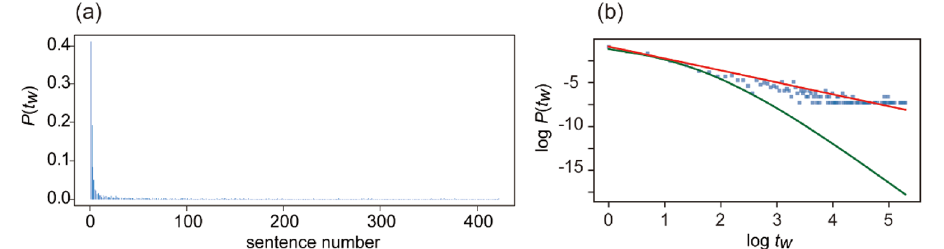
and ( b ) log–log scale plot. The red straight line and the green curve t , for w show optimized fitted results by use of the hierarchical distribution ( ) (see Sect. 3.4) and the q-exponential distribution,